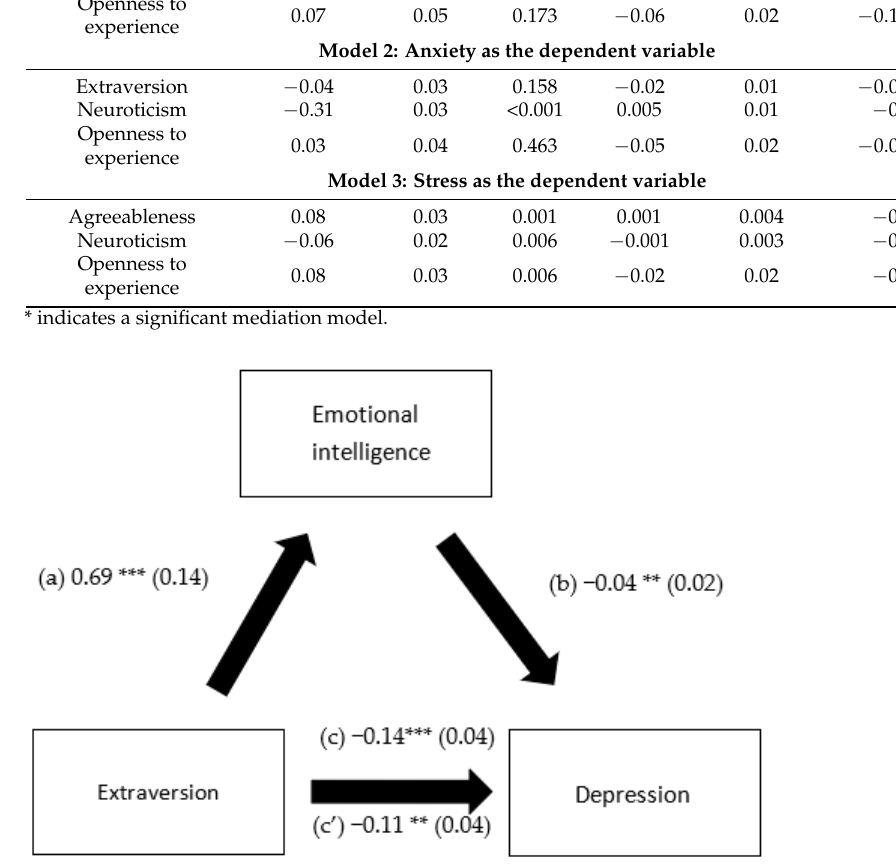
Figure 1. (a) Relation between extraversion and emotional intelligence (R 2 = 0.294); (b) relation between emotional intelligence and depression (R 2 = 0.284); (c) total effect of the relation between extraversion and depression (R 2 = 0.270); and (c’) direct effect of the relation between extraversion and depression. Numbers are displayed as regression coefficients (standard error). ** p < 0.01; *** p < 0.001.